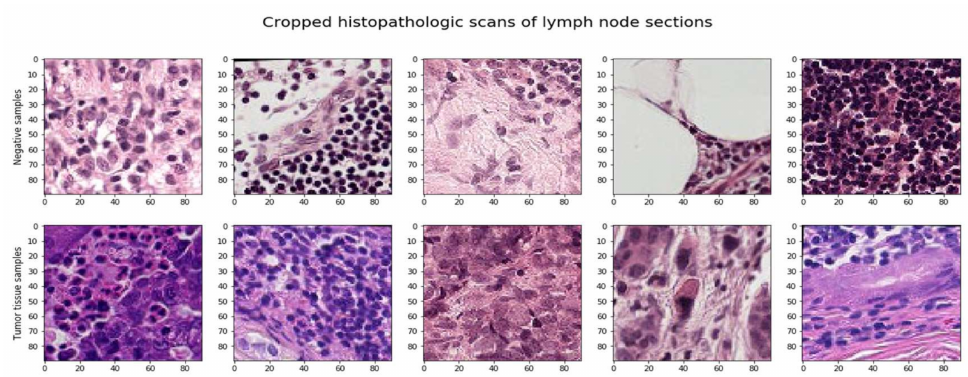
Figure 3. Cropped histopathological scan